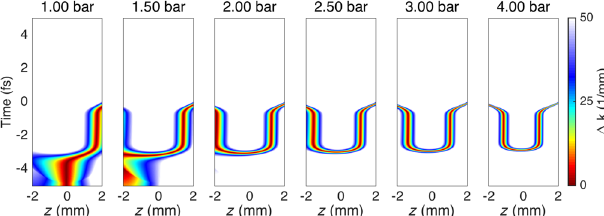
FIG. 9. Spatiotemporal phase-matching maps as a function of HHG target pressure in Ne. Calculated on-axis phase mismatch as a function of propagation position and time within the pulse for 300-eV radiation generated in neon for our experimental con- ditions and target pressures of 1 – 4 bar. The intensity in our target only has a field strength sufficient to generate 300 eV radiation between − 1 to 1 mm in the propagation direction.